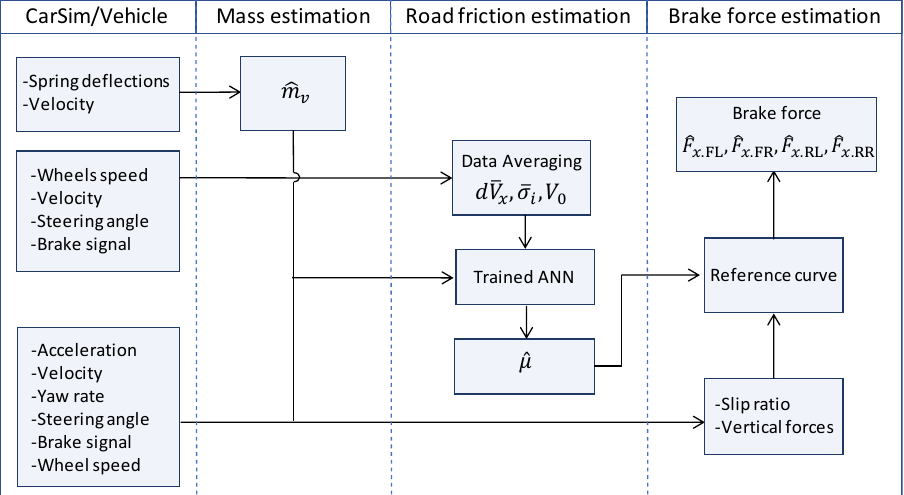
Figure 1. Entire structure of the proposed estimation systems.